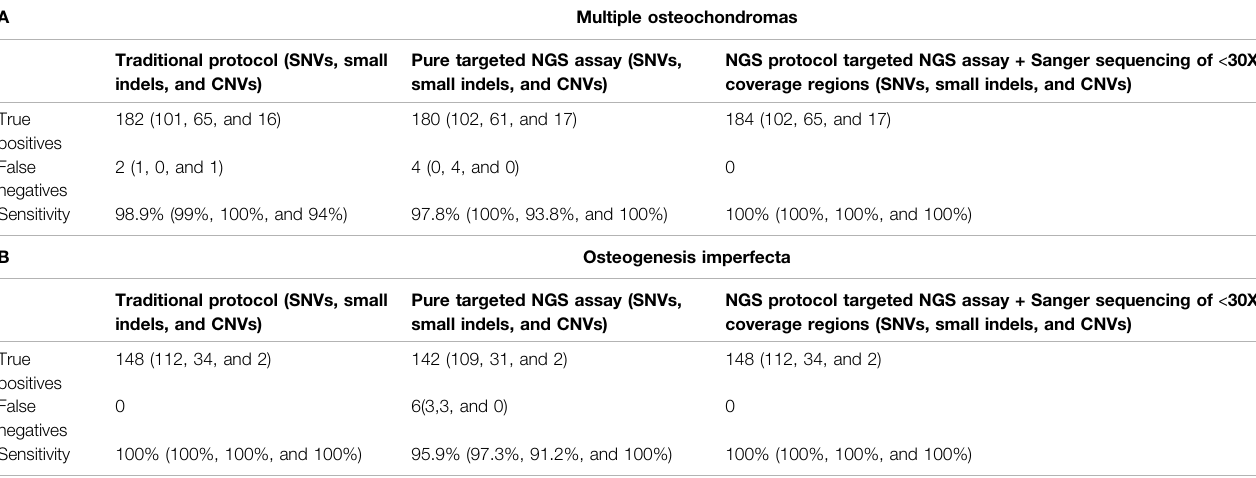
TABLE 2 | Comparisons among the number of true-positive pathogenic variants, false-negative (missed) calls, and sensitivity associated with the traditional protocol, the NGS pure assay, and the NGS assay with Sanger sequencing of all low read depth regions. In brackets, the same values are divided by the mutation type. A Multiple